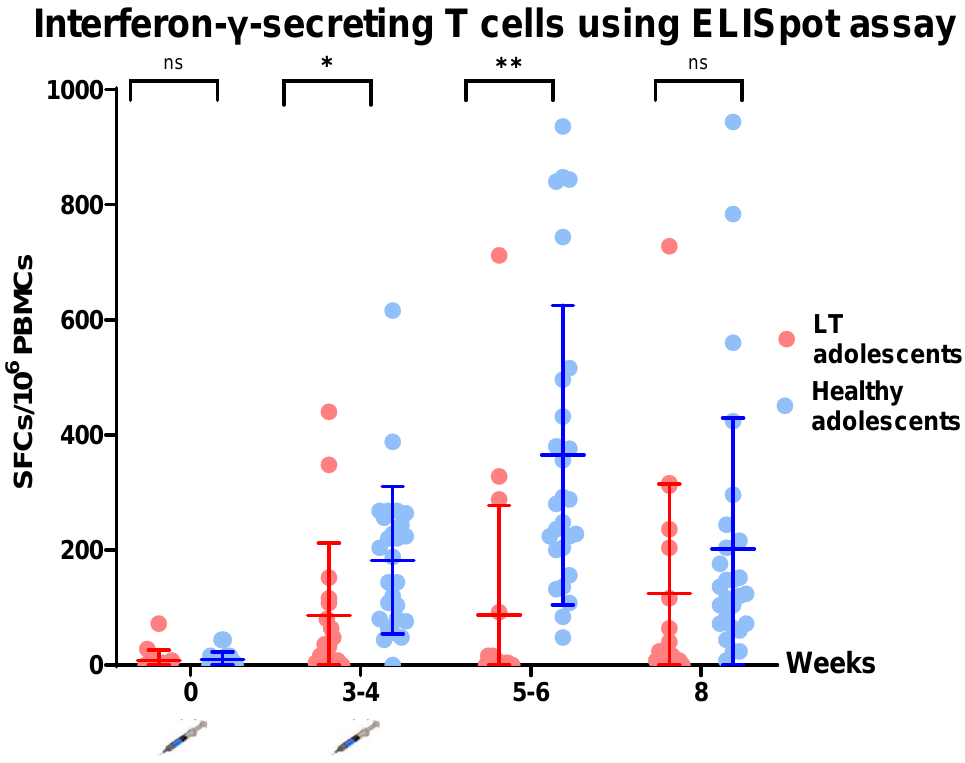
Figure 3. Comparison of T-cell-specific response to SARS-CoV-2 spike peptide pools (S1 + S2) measured using interferon-gamma ELISpot. Data points are reciprocals of the individual. Line indicates geometric mean titer and bar indicates 95% confidence interval. * indicates p < 0.05; ** indicates p < 0.01. ns—no statistical